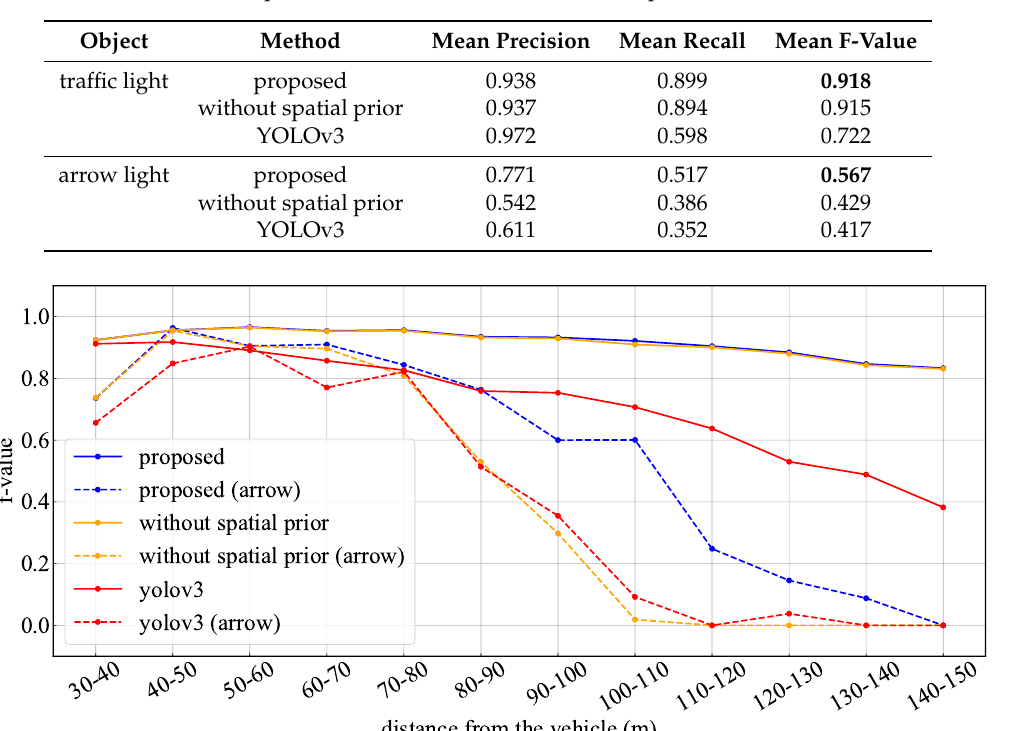
Table 4. Experimental results with or without the prior information.